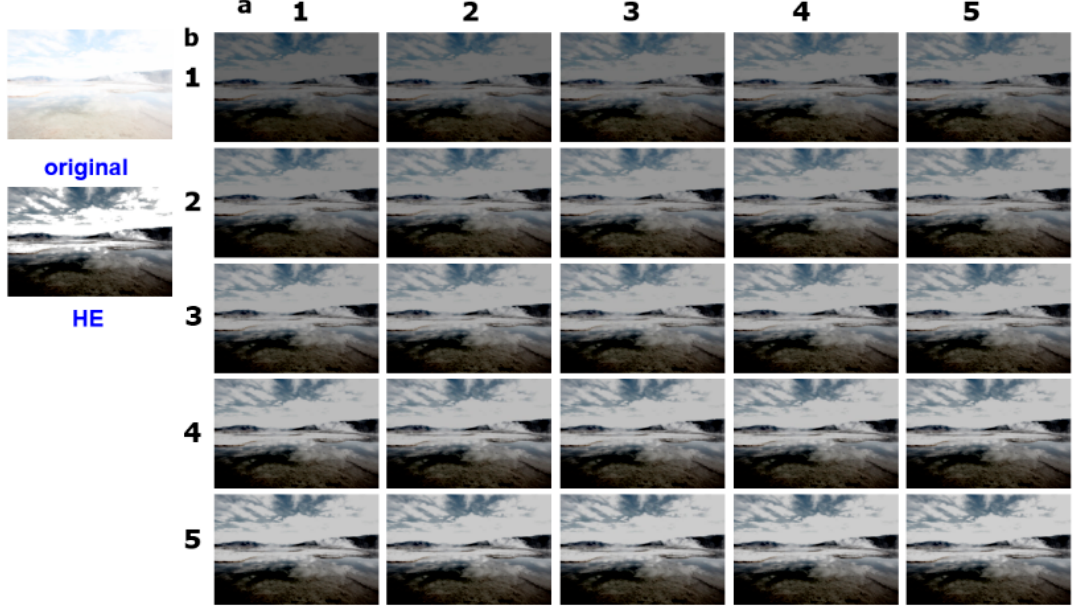
Figure A1. Image, Landscape [27], processed by GA with different a and b .